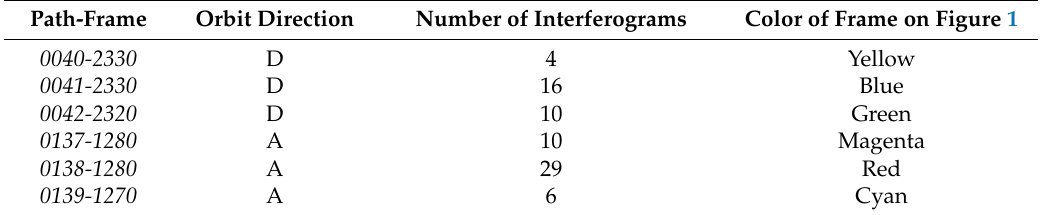
Table 1. Data used in this study. The letters A and D denote ascending and descending, respectively. Path-Frame Orbit Direction Number of Interferograms Color of Frame on Figure 1 4 Yellow Blue Path-Frame Orbit Direction Number of Interferograms Color of Frame on Figure 1